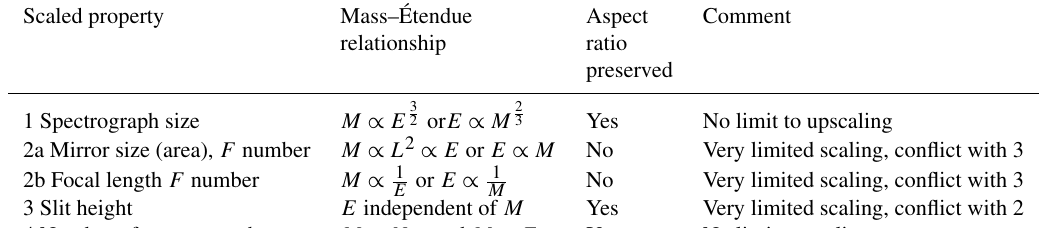
Table 1. Summary of scaling options for the improvement of spectrograph light throughput at a given spectral resolution. Scaled property